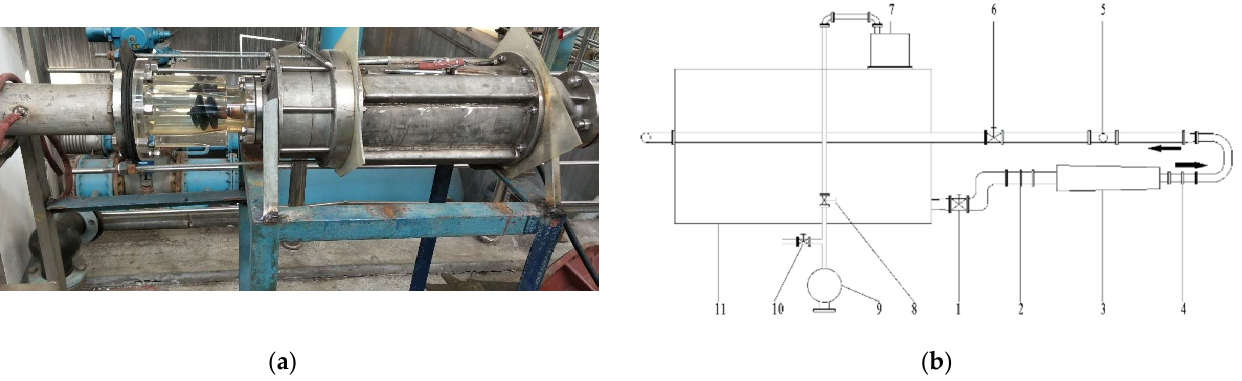
Figure 4. Experimental images of the submerged pump characteristics. ( a ) Physical model and ( b ) schematic diagram of the experimental system.